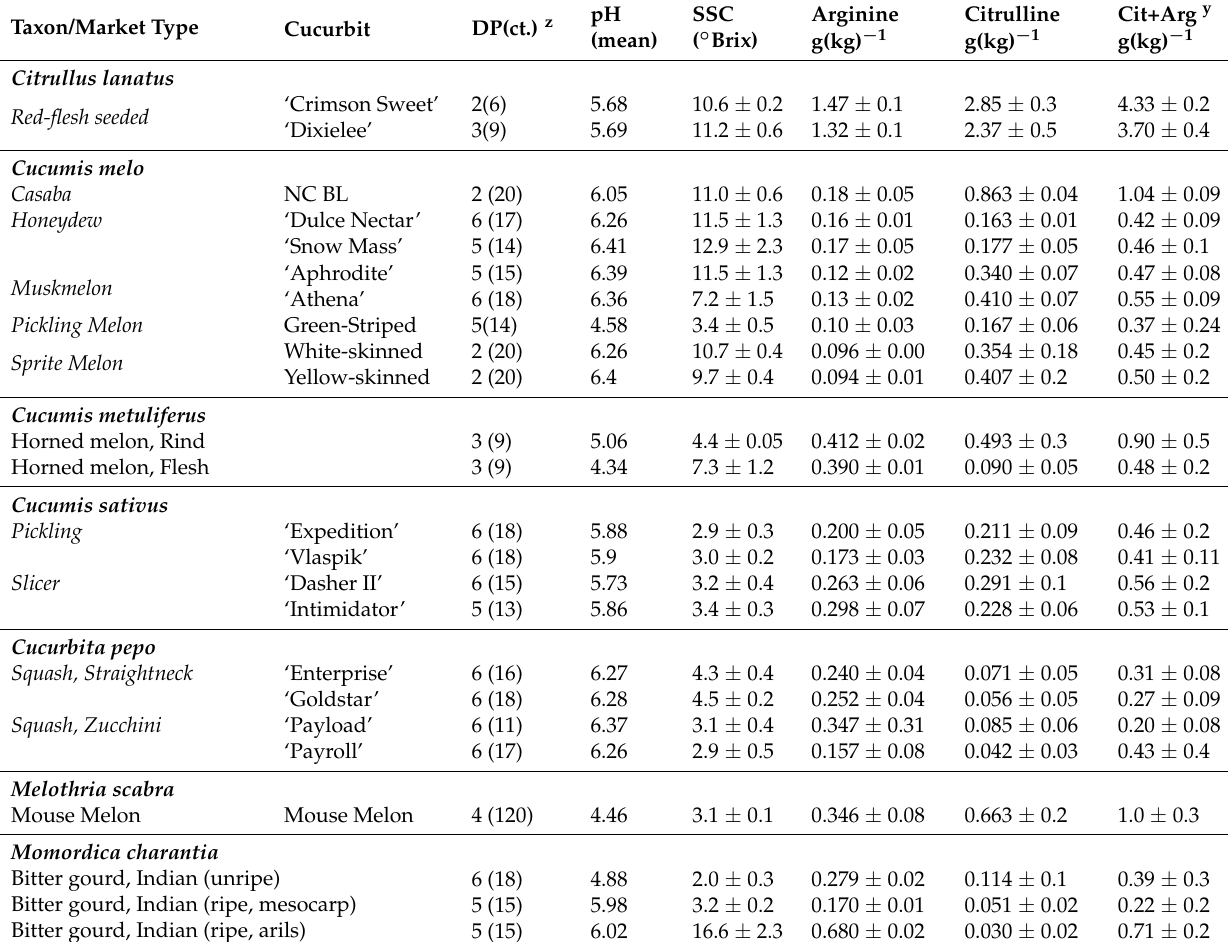
z Data points (DP) represent number of plots, whose values are averaged (ct. = count of total fruit sampled over all plots). y Combined citrulline and arginine